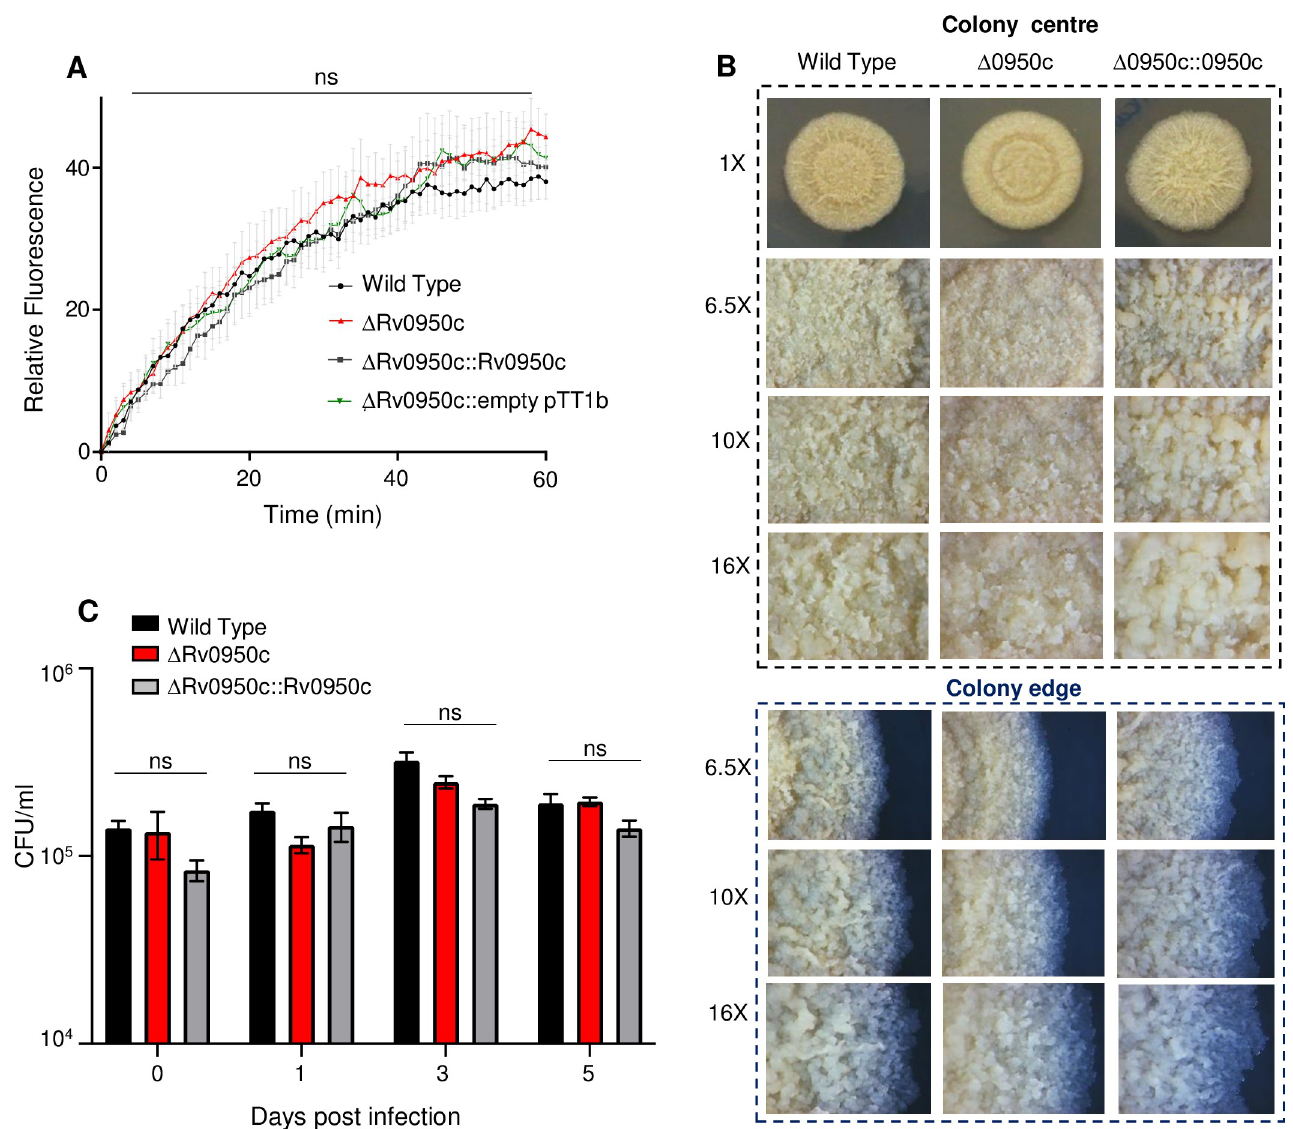
Fig 6. Assessment of cell wall permeability, colony morphology and intracellular survival of the Δ 0950c mutant. (A) Ethidium bromide uptake as a measure of cell wall permeability. A plate-based fluorescence readout over 60 min incubation with EtBr (0.25 μ g/ml) was used. Data was averaged from duplicate readings of three biological replicates for each strain. As ethidium bromide enters the cell, fluorescence is increased (B) Morphology of colonies from the Δ 0950c mutant. Cultures were grown to mid-log phase (OD600 nm ~ 0.5) in 7H9 media supplemented with OADC and Tween. Ten microliters of each were spotted onto 7H11 media and incubated at 37˚C for 21 days. Images were captured at magnifications shown to compare shape and structures on colonies (centre and edge). (C) Intracellular survival of the wild type, Δ 0950c mutant and genetically complemented strains. The mutant, wild type and genetically complemented derivative were infected in activated THP1 cells and survival monitored by enumerating colony forming units (CFU/ml) over a period of 5 days. ns: Not significant.